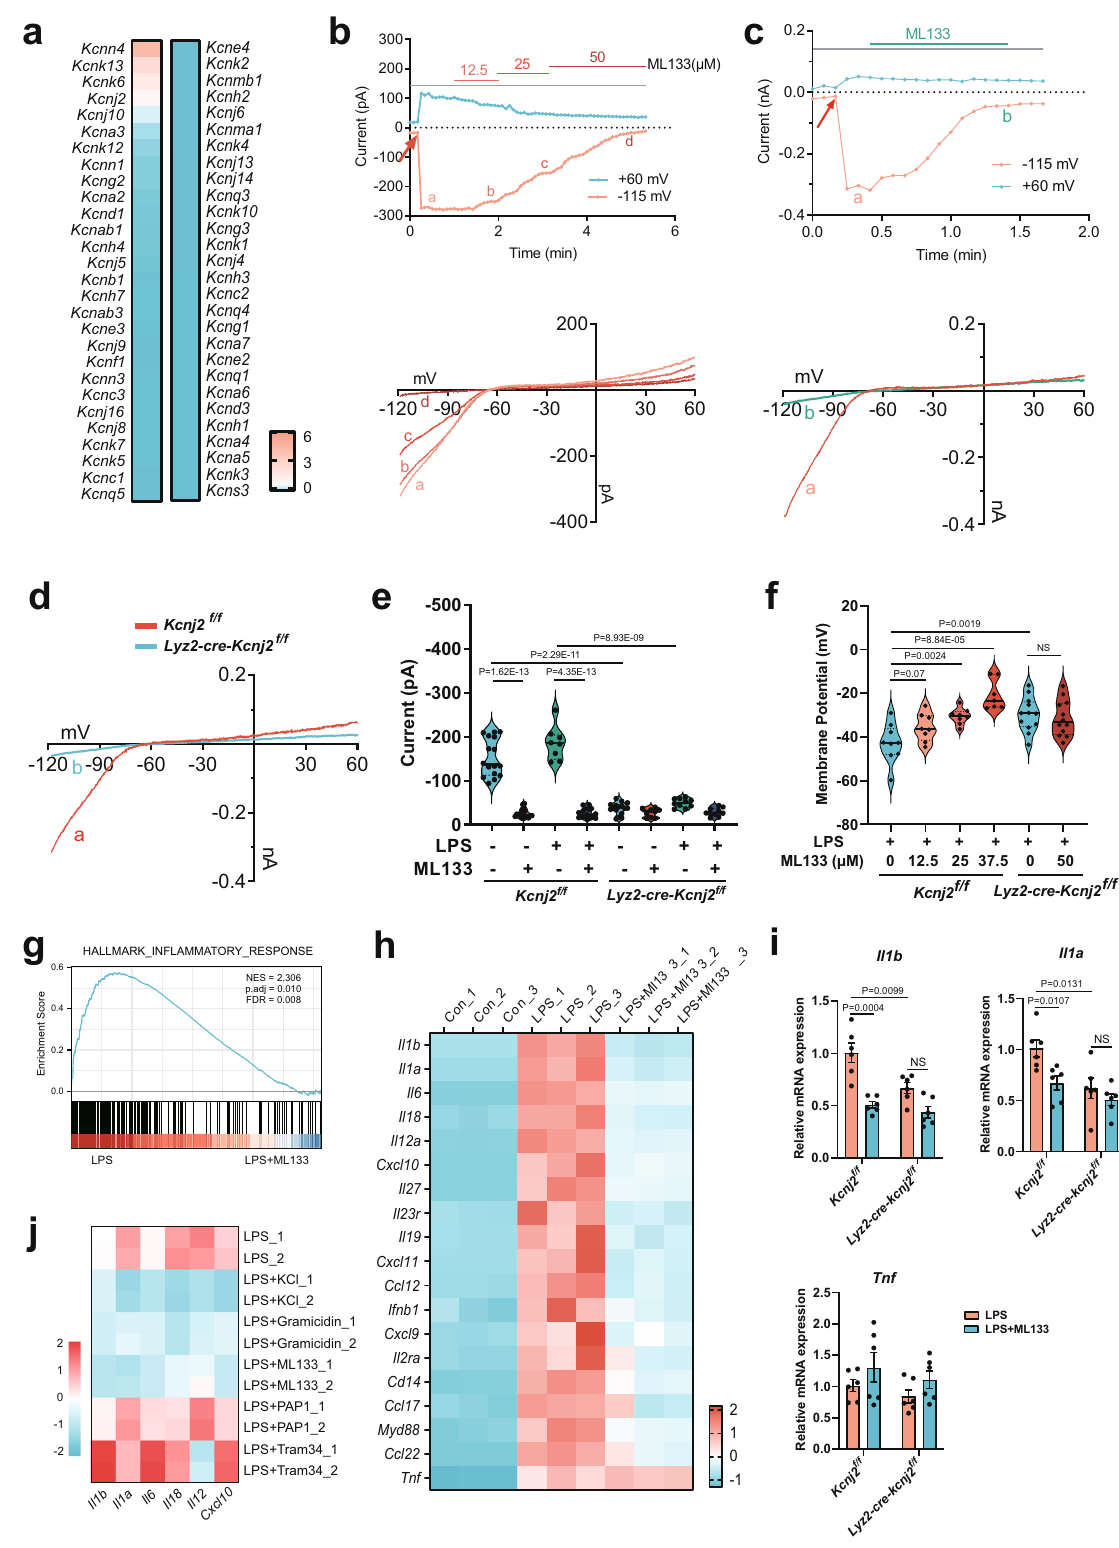
Fig. 3L), showing a similar phenotype upon serine starvation 28,29 . GSEA also highlighted signi fi cant enrichment in ‘ amino acid transport ’ and ‘ serine, glycine, one-carbon (SGOC) metabolism ’ (Fig. 3k). We further analyzed the differentially expressed genes shared between ML133 treatment and Kir2.1 de fi ciency by pathway enrichment analysis. Besides the common